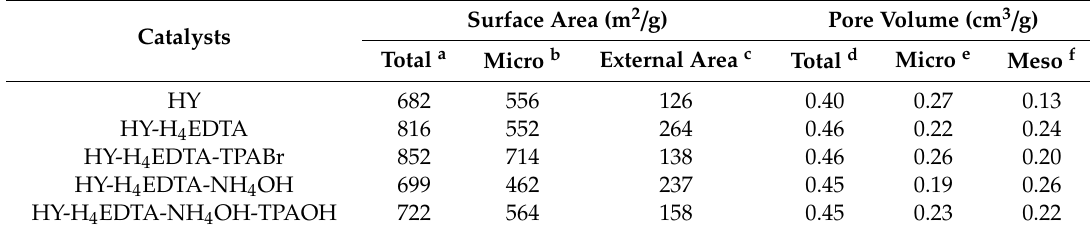
Table 2. Characterization results of pore volumes and BET surface areas of pretreated zeolites.